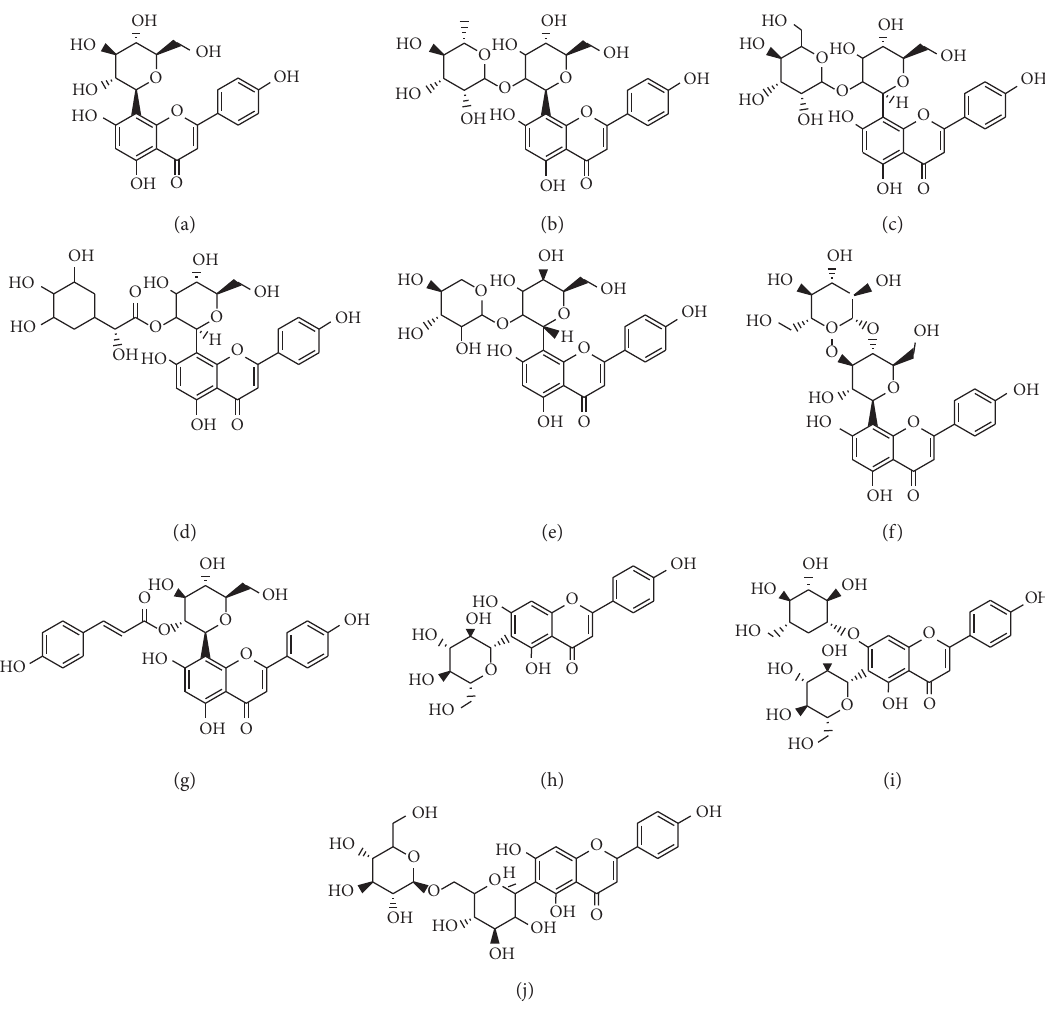
Figure 1: Structures of vitexin (apigenin-8-C- β -glucopyranoside) and its analogs. (a) Vitexin (apigenin-8-C-B-glucopyranoside). (b) Vitexin 2 ″ -O-rhamnoside. (c) Vitexin 2 ″ -O-glucoside. (d) 2 ″ -O-galloylvitexin. (e) Vitexin 2-O-xyloside. (f) Vitexin 4 ″ -O-glucoside. (g) Vitexin 2 ″ -O-p-trans-coumarate. (h) Isovitexin (apigenin-6-C-B-glucopyranoside). (i) Isovitexin-7-O-glucoside.(j) Isovitexin 6 ″ -O-